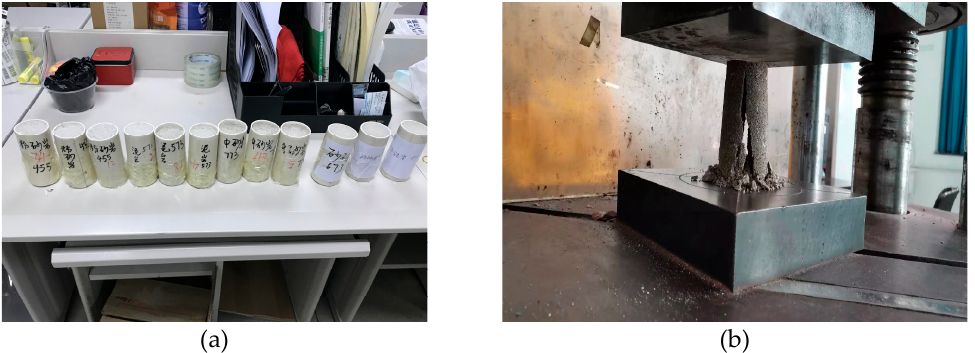
Figure 6. Tests performed on the samples: ( a ) view of the test samples, a group of three test samples from left to right are siltstone, mudstone, medium sandstone and sandy conglomerate; ( b ) uniaxial compressive strength measurement on the prepared test samples. Table 3. Proportions for preparing the materials similar to the overlying strata in Tashidian Erjingtian